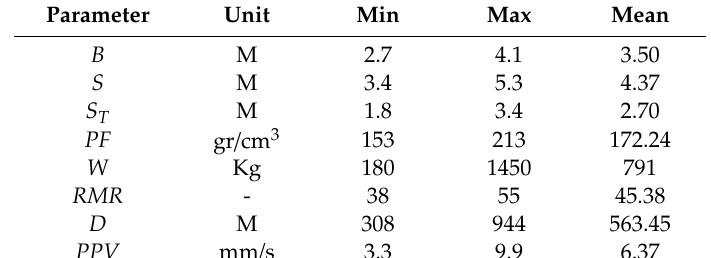
Table 1. The ranges of the model inputs and outputs and some other information. Parameter